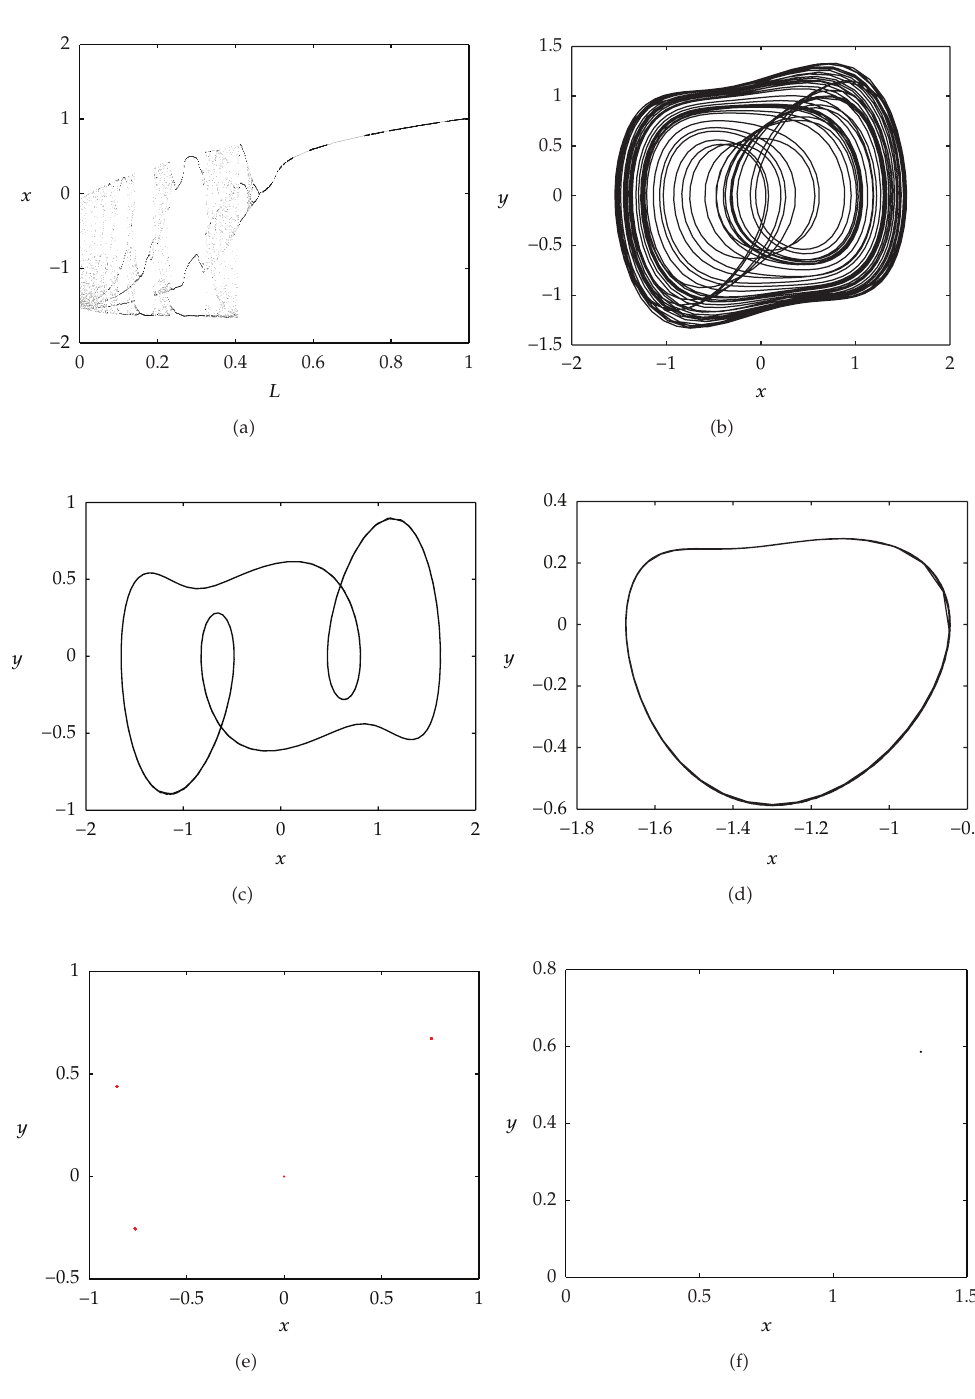
Figure 9: (cid:6) a (cid:7) Bifurcation diagram of the system (cid:6) 4.2 (cid:7) in L ∈ (cid:6) 0 , 1 (cid:7) . (cid:6) b, c, and d (cid:7) Phase portraits for three values of L in Figure 9 (cid:6) a (cid:7) . (cid:6) e (cid:7) Pioncar´e map of the system (cid:6) 4.2 (cid:7) for L (cid:8) 0 . 3. (cid:6) f (cid:7) Pioncar´e map of the system (cid:6) 4.2 (cid:7) for L (cid:8) 0 .